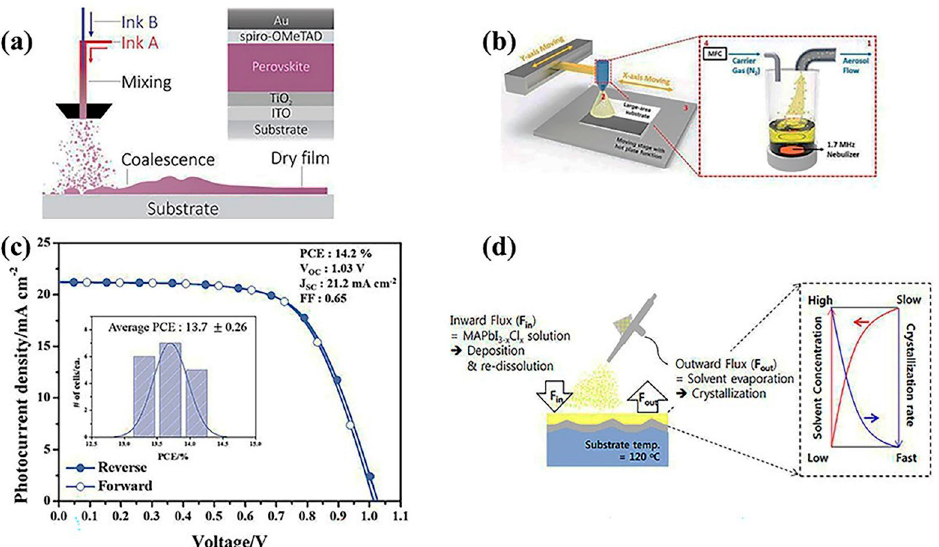
Figure 5. ( a ) Schematic of concurrently pumped ultrasonic spray coating for perovskite precursor deposition [59]. Copyright 2016 Royal Society of Chemistry. ( b , c ) Schematic representation of the mega-sonic spray-coating process and J–V curves of PSCs, respectively [63]. Copyright 2018 John Wiley and Sons. ( d ) Schematic diagram of the spray coating process [64]. Copyright 2016 The Royal Society of Chemistry.